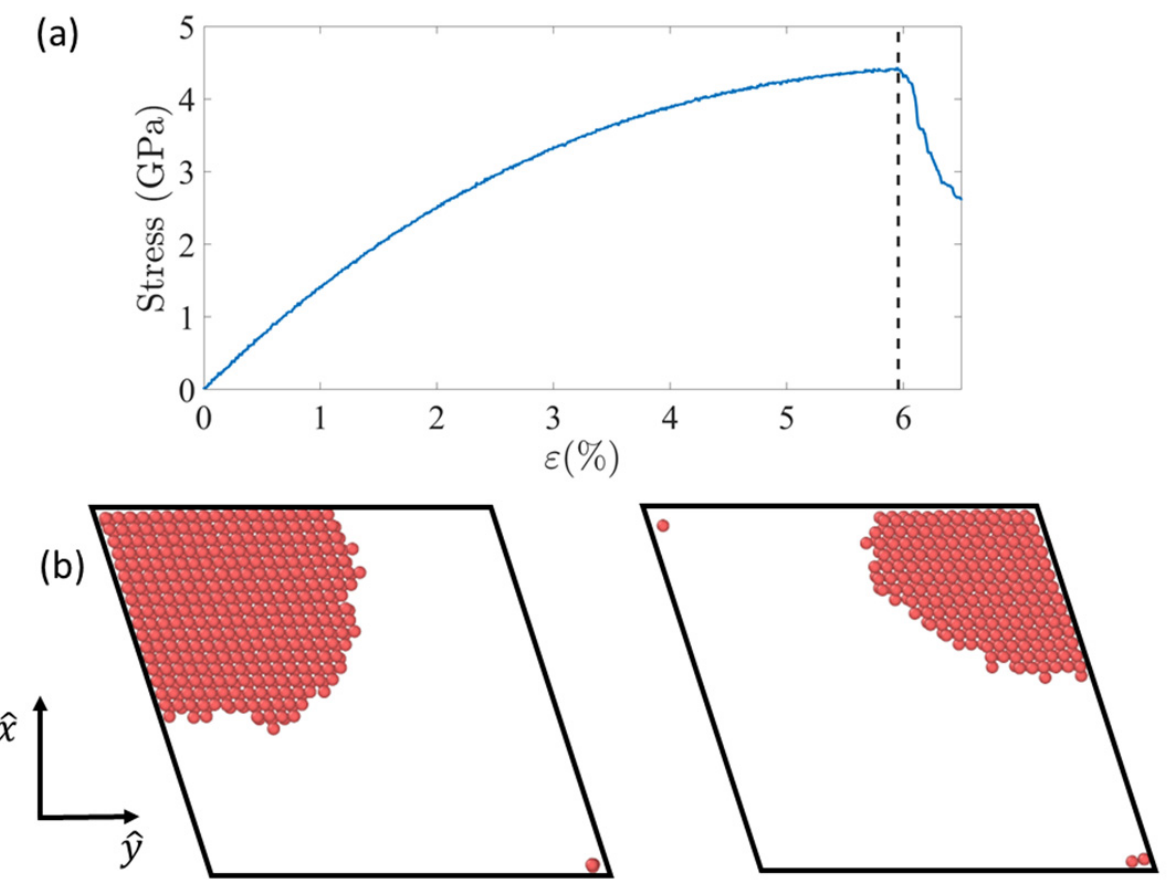
Figure 2. ( a ) The engineering stress ‐ strain plot during tensile loading in a simulation at 100 K. The strain at which dislocation was nucleated is marked with a dashed line. ( b ) Nucleation from the acute (left) and obtuse (right) angles. For clarity, only the atoms in stacking fault are visualized and the rhombic contour of the cross ‐ section is sketched.